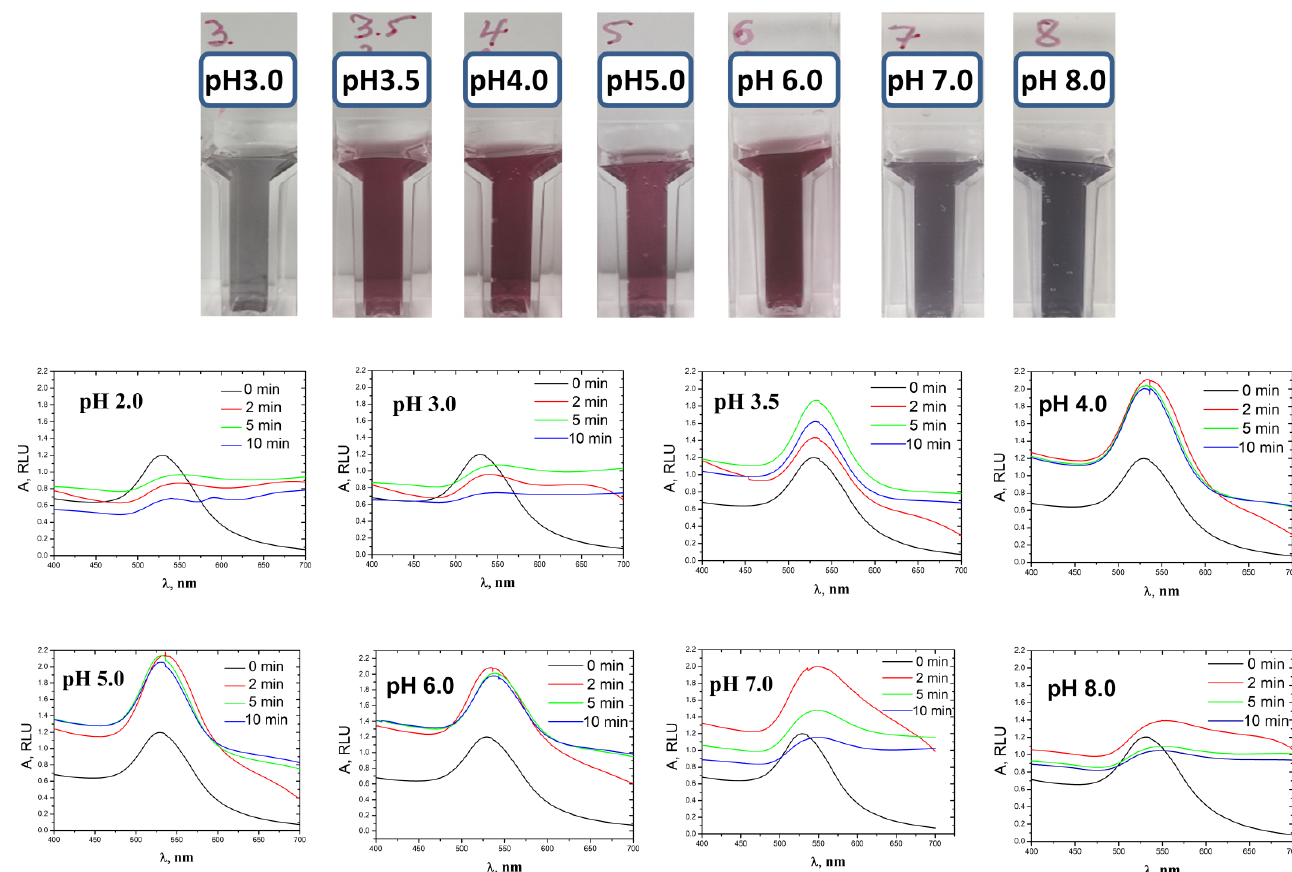
Figure 2. Spectra of colloidal suspensions of gold nanoparticles during the reduction of HAuCl 4 with NH 2 OH at different pH and reaction time. The black lines correspond to the spectra of the colloidal suspensions without amplification.